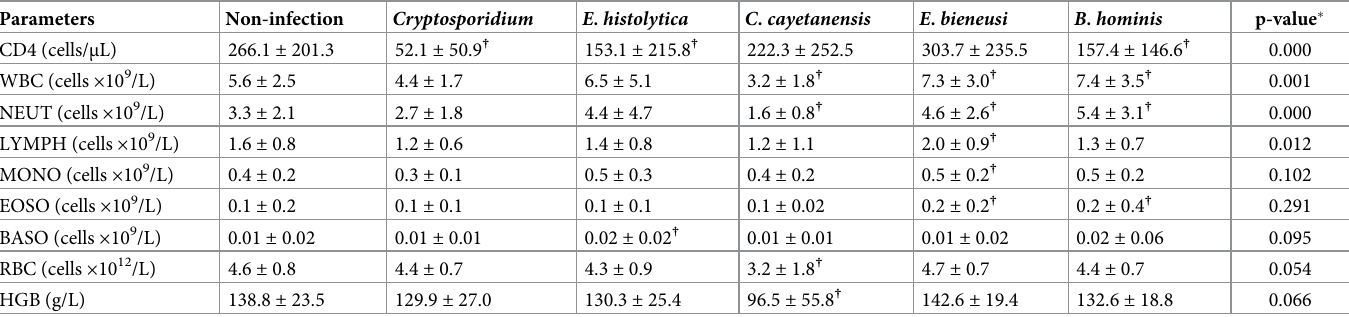
� p-values indicated the comparison among different infection conditions using Kruskal-Wallis test. † Statistically different compared with non-infection, using Kruskal-Wallis